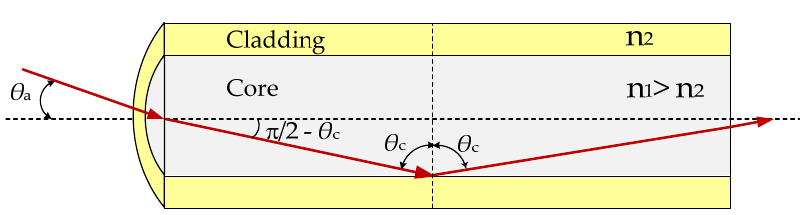
Figure 3. Transmission of a ray of light inside an optical fiber. This value is of great importance for the coupling of light to optical fiber conductors. The greater the amount of light that the fiber can accept, the greater the transmission distance that can be reached, although if it is very large the system bandwidth